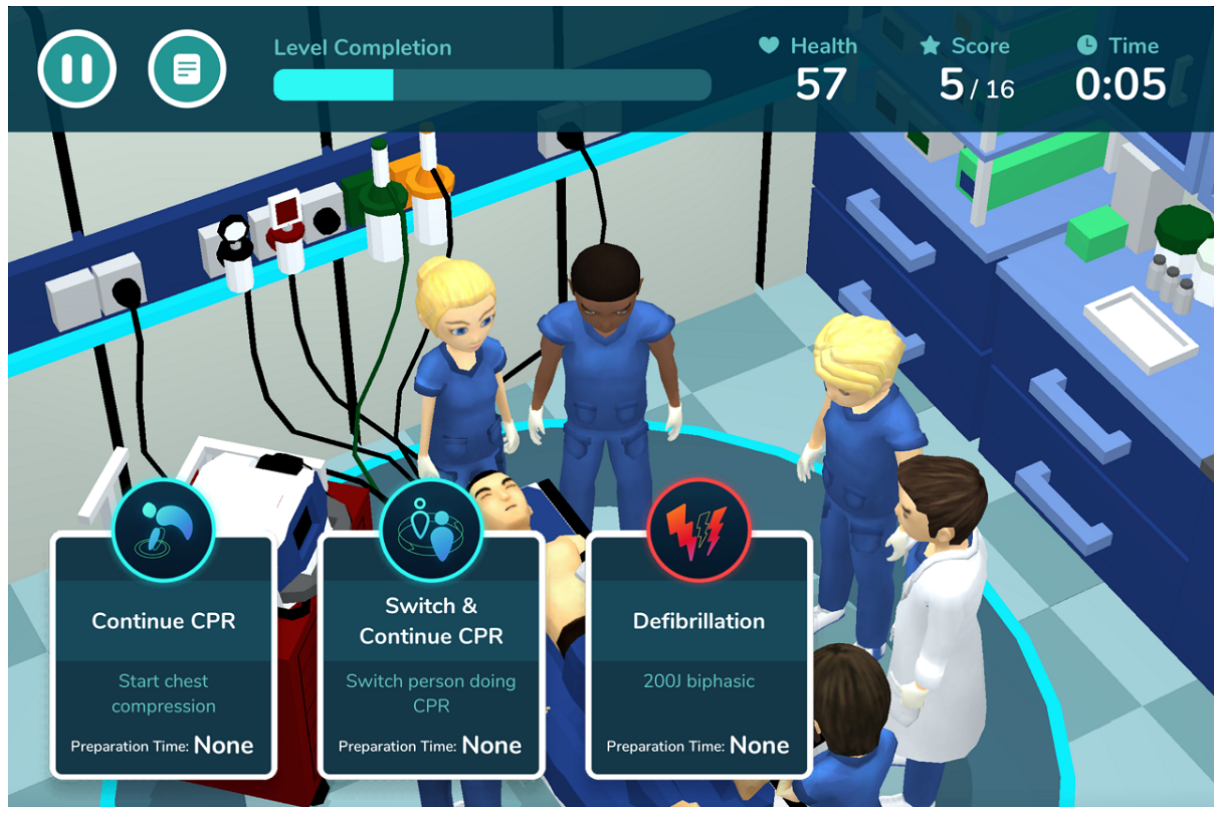
Figure 1. Screenshot from Resus